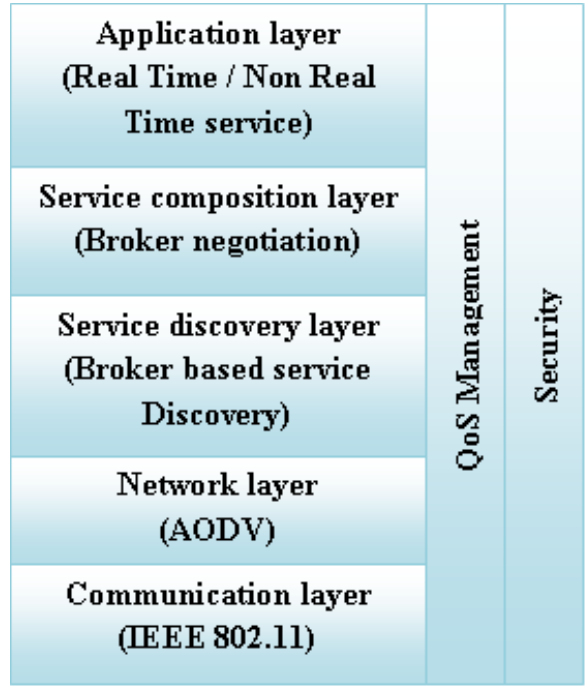
Figure 3. Layered architecture of QoSDSBS.